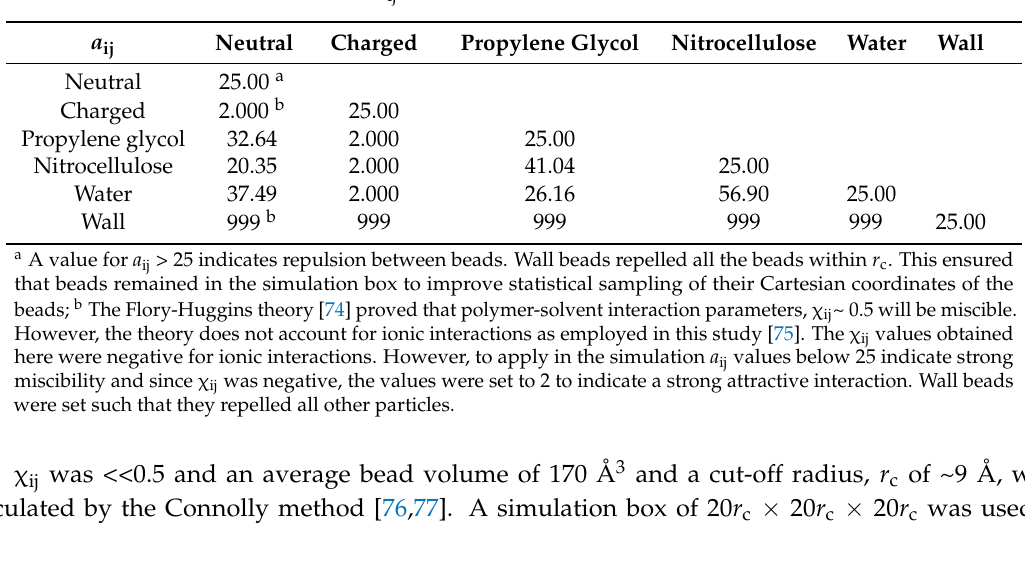
Table 3. a ij values used for DPD